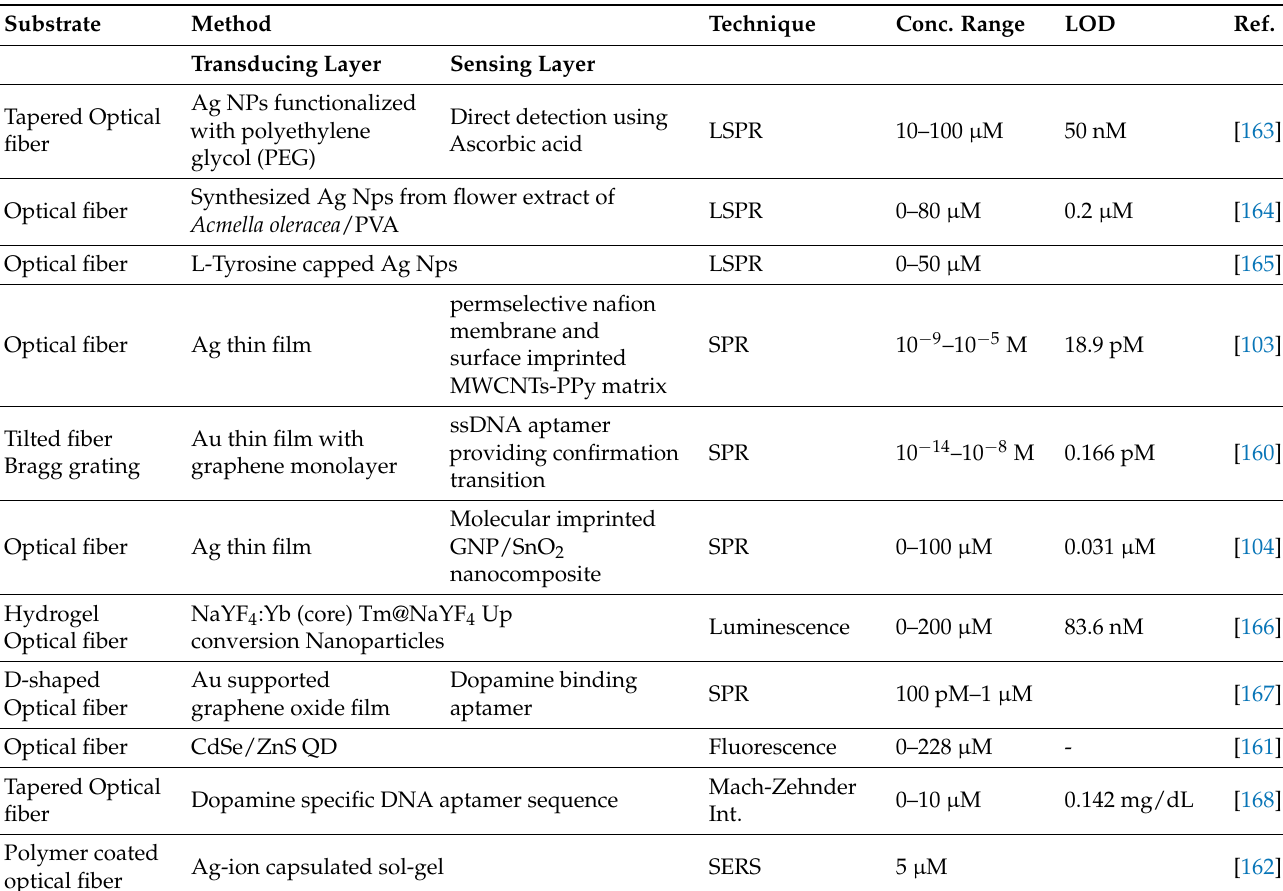
Table 4. A comparison of optical fiber Dopamine sensors reported in